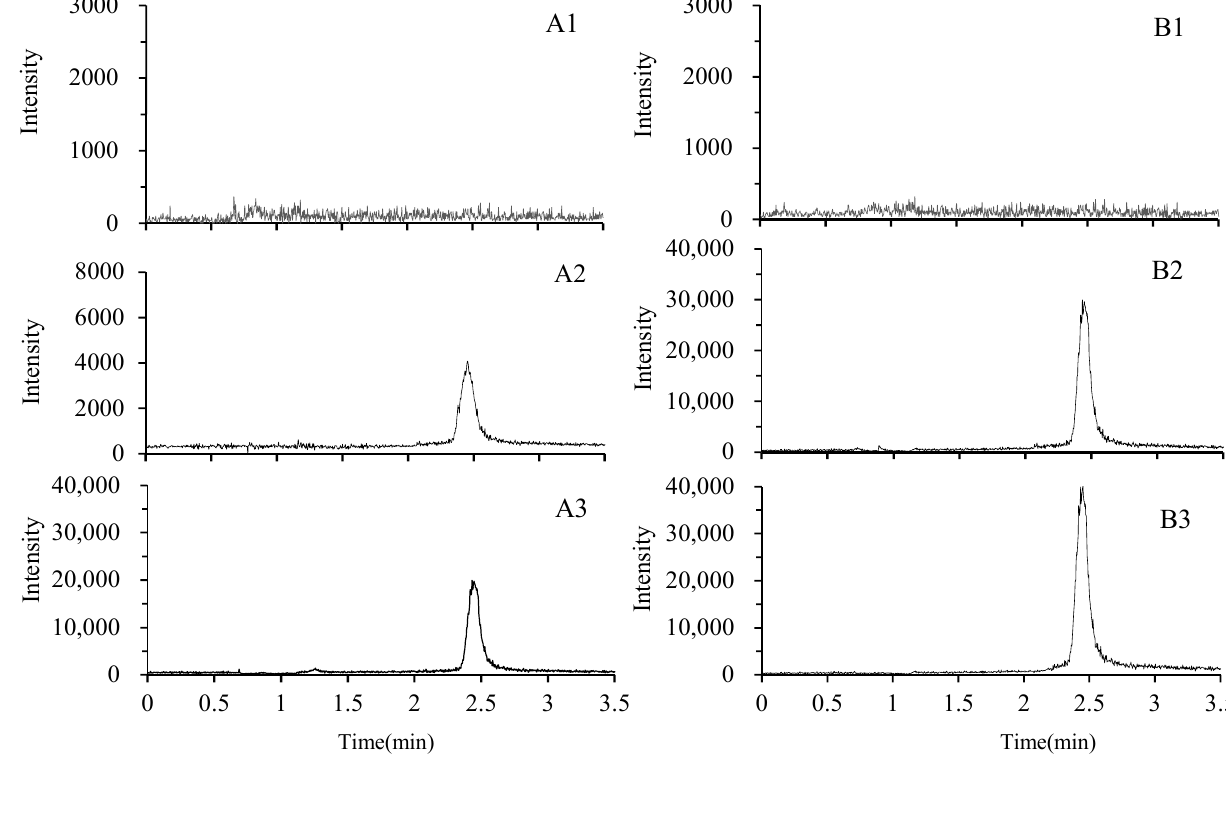
Figure 2. Typical UPLC-MS/MS chromatograms of ellagic acid in rat plasma ( A ) and liver ( B ). ( A1 ) blank plasma; ( A2 ) blank plasma spiked with ellagic acid (10 ng/mL); ( A3 ) plasma 0.5 h after oral administration of a single dosage 50 mg/kg ellagic acid; ( B1 ) blank liver sample; ( B2 ) blank liver sample spiked with ellagic acid (100 ng/g); ( B3 ) liver sample 0.5 h after oral administration of a single dosage of 50 mg/kg ellagic acid.